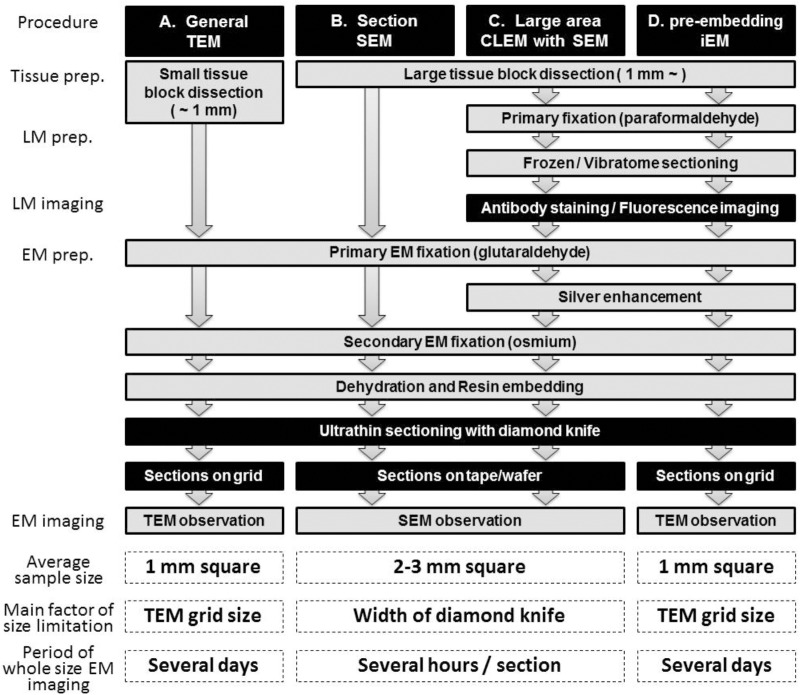
Schematic illustration of LA-CLEM. Sample preparation procedures for general TEM (A), section SEM (B), large-area CLEM (LA-CLEM) with SEM (C) and pre-embedding immune-EM (D) are shown. Human biopsy or autopsy specimens, marmoset brain specimens and rodent tissue samples have typically been processed for general TEM observation and for diagnostic purposes. More recently, large-area observation of tissue sections has been conducted using SEM, including multibeam SEM. Localization of proteins and nucleotides (RNA/DNA) is possible using iEM. The combination of large-area observation with iEM is the key to LA-CLEM imaging. Detailed procedures for LA-CLEM are presented in the main text. Numerical comparisons of the average sample size, the main factor of size limitation, and the period of whole size EM imaging between each procedure are provided at the bottom of this chart. The average sample size for TEM observation is a section approximately 1 mm2
(A,D). It requires several days to image the entire 1 mm2 area on the grid. In contrast, a 2–3 mm2 section is the average size restricted by the width of the diamond knife, and it requires several hours to image the entire 2–3 mm2 area on the silicon wafer.